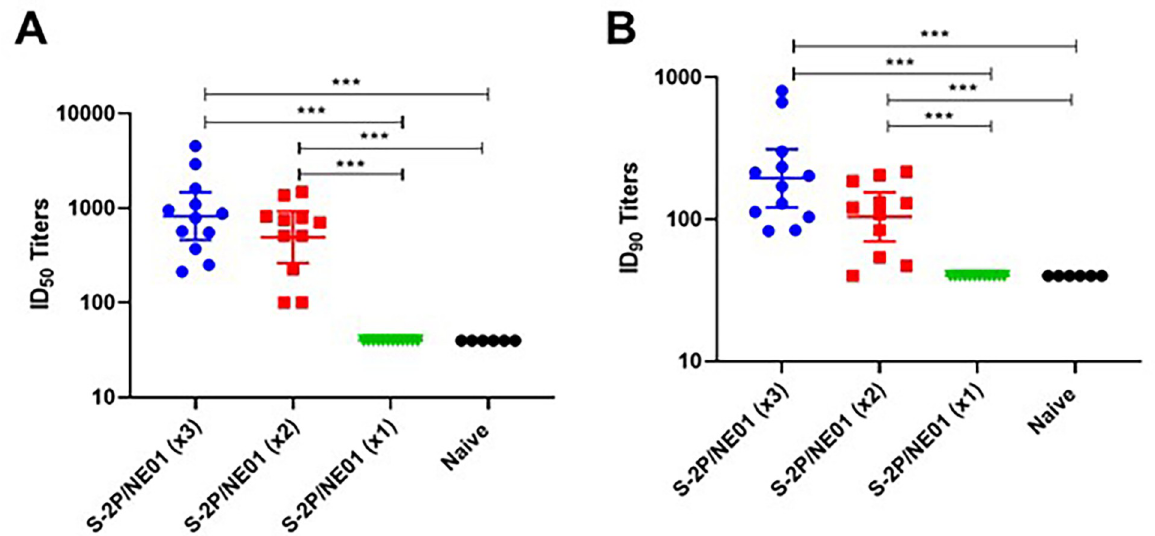
Fig 4. Neutralizing antibody titers from hamsters prior to challenge. Sera obtained from hamsters 10 days prior to challenge were analyzed by neutralization assay with pseudovirus expressing SARS-CoV-2 spike protein to determine the ID 50 (A) and ID 90 (B) titers. Statistical significance between groups was calculated by one-way ANOVA; � p < 0 . 05 , �� p < 0 . 01 , ��� p < 0 . 001